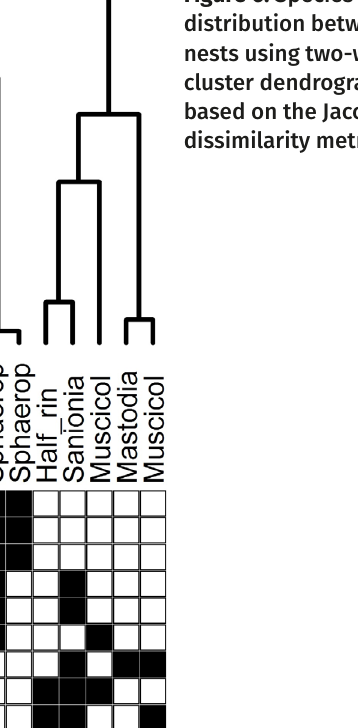
Figure 6. Species distribution between nests using two-way cluster dendrogram based on the Jaccard dissimilarity